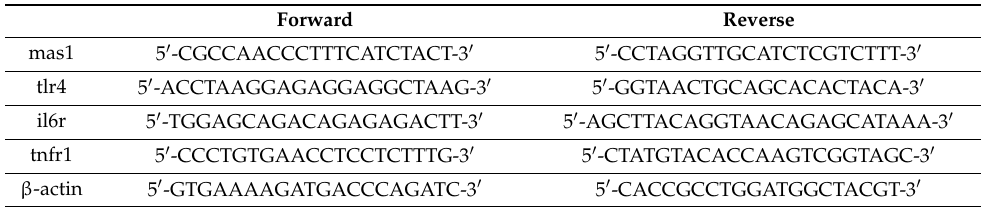
Table 2. Primer sequences for qPCR.